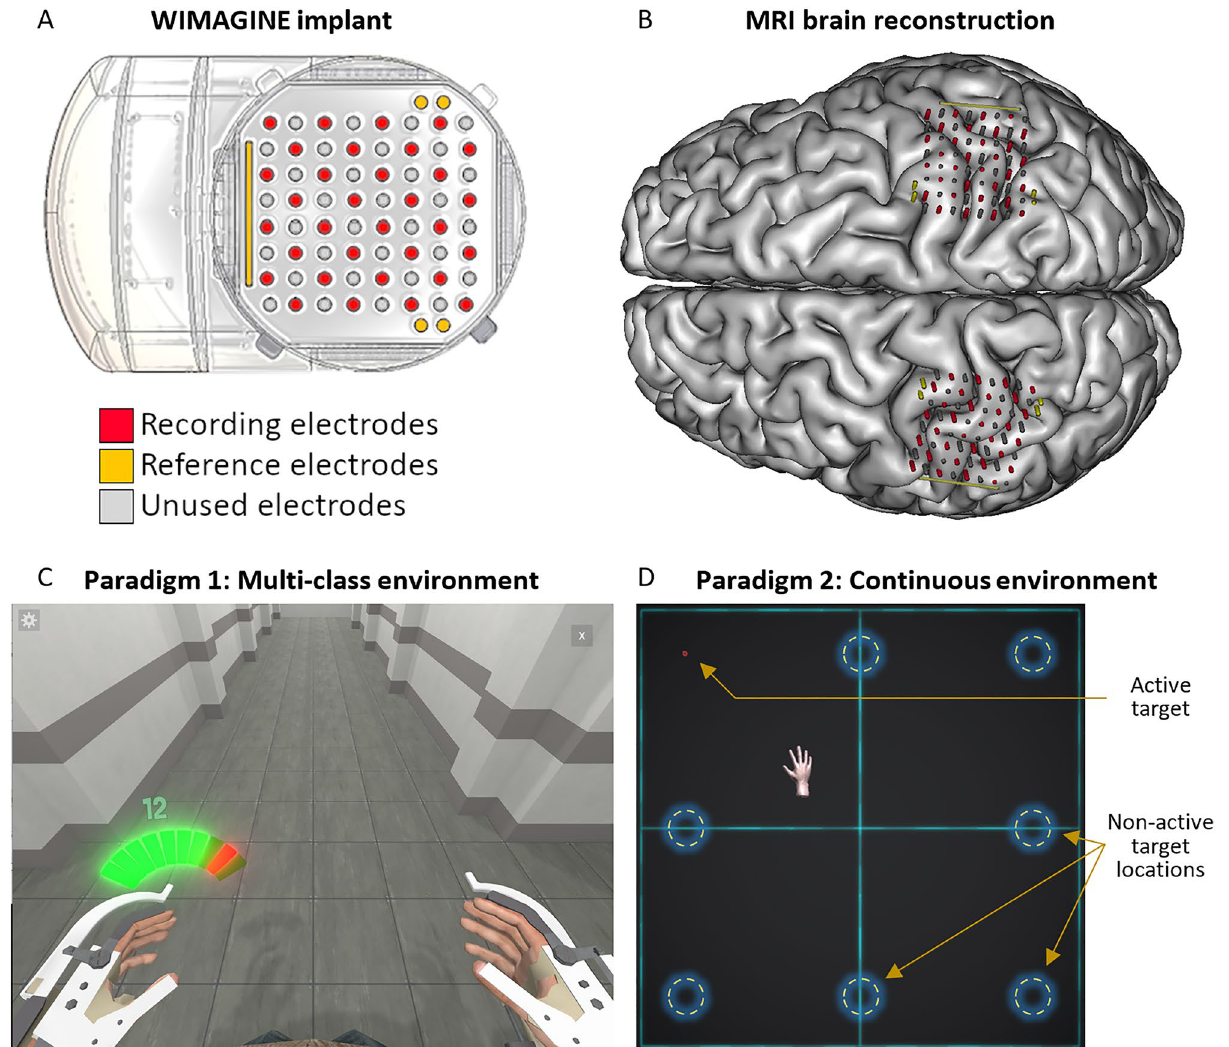
Figure 2. ( A ) Schematic view of a WIMAGINE implant. ( B ) Position of the electrodes of each WIMAGINE implant over the right and left sensorimotor cortex on a reconstruction of the subject’s brain from MRI. ( C , D ) Virtual environments used for each series of experiment. ( C ) The multi-class discrete BCI experiment (paradigm 1) was done with a virtual avatar in an exoskeleton seen from a first-person point of view. The subject used motor imagery to activate and maintain four mutually exclusive movement states: rotation of the left or right wrist or movement of the left or right hand. ( D ) The bi-dimensional continuous BCI experiment (paradigm 2) was done with a two-dimensional center-out task on a computer screen. The subject used motor imagery to control continuously in two dimensions the direction and velocity of the hand-shaped decoder with an accuracy of 71.5% ± 7.4%. The estimated control decoder labels had a global accuracy of 64.5% in paradigm 1 (Fig. 3A). In paradigm 2, the estimated control decoder labels were considered correct when the angle between the estimated label and the true label was less than 60°. The estimated control decoder labels had an accuracy of 63.3% (Fig. 3B). Simulation of online use of the aaBCI. The capabilities for auto-adaptive training of control decoders in the aaBCI framework was evaluated in an online simulation. The decoding capabilities of the control decoder of the multi-class BCI (paradigm 1) were assessed using a generalized version of the AUC of the ROC for non- binary classification 26 . The decoding capabilities of the control decoder of the continuous bi-dimensional BCI (paradigm 2) were assessed using the cosine similarity between the prediction (control decoder output) and the optimal prediction. The optimal prediction at each time moment is a Cartesian vector between the current cur- sor position and the target position 3 . For paradigm 1, the mean and standard deviation of the AUC of the ROC were 0.7404 ± 0.0379 (Fig. 3C). For paradigm 2, the mean and standard deviation of the cosine similarity were 0.1211 ± 0.0623 (Fig. 3D). As a com- parison, with an aaBCI update perfomed with a shuffled cMTP decoder output these results were 0.5173 ± 0.0603 for the multi-class BCI and 0.0036 ± 0.0217 for the continuous BCI, wheras with an update performed with fully